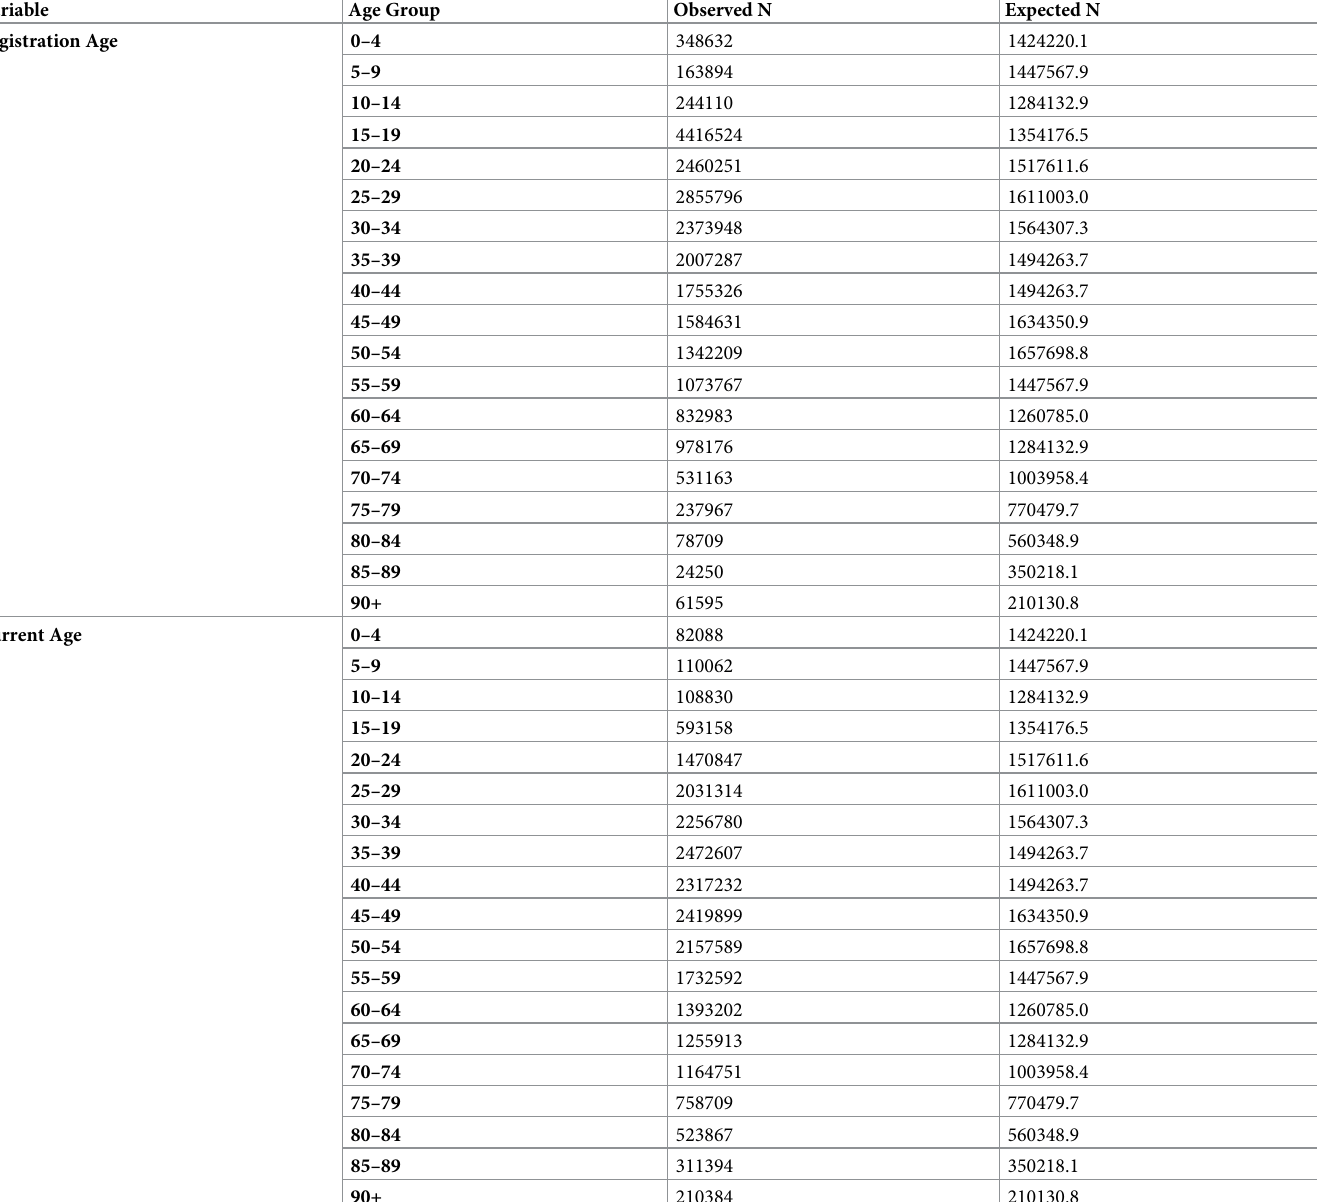
Table 2. Observed and expected frequencies for age group at registration and current age group compared to the U.K. general population (analysed using dataset 1 –March